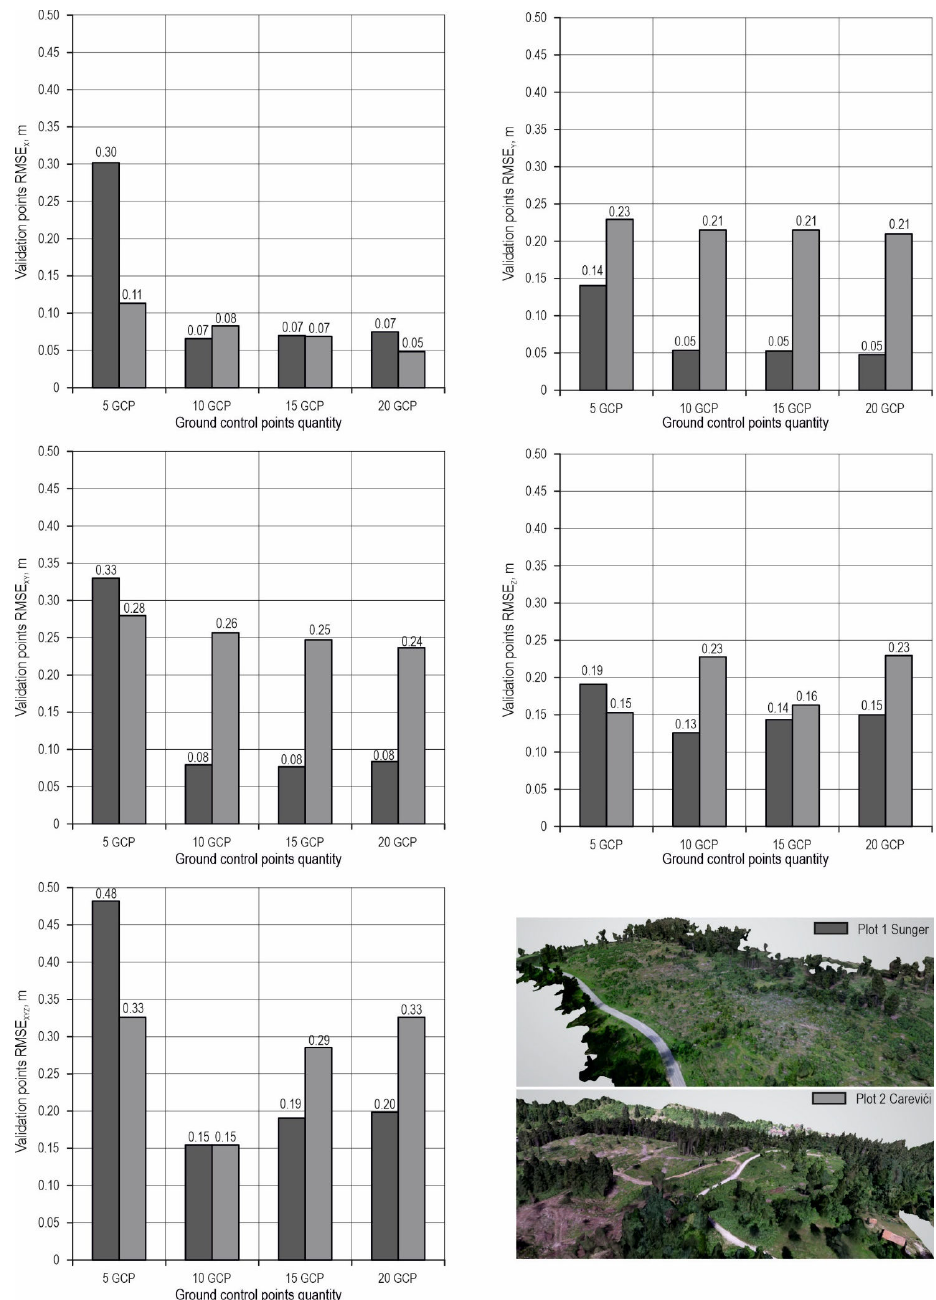
Figure 5. Horizontal and vertical RMSE on Plots 1 and 2. The positional error of both plots is shown in Figure 6. Generally, the increase in the number of GCPs used for the alignment of original images reduced the positional error. In Plot 1, median values were ∆ p 5GCP = 0.2305 m, ∆ p 10GCP = 0.0403 m, ∆ p 15GCP = 0.0562 m and ∆ p 20GCP = 0.0424 m. Plot 2 followed a similar pattern with one exception—GCP class with ten points, ∆ p 5GCP = 0.1500 m, ∆ p 10GCP = 0.2220 m, ∆ p 15GCP = 0.0817 m and ∆ p 20GCP = 0.0507 m. This one exception in Plot 2 can be explained by difficulties connected to the identification of points depending on the level of zoom on relatively scarce point clouds brought by using a different tree-marker spray in Plot